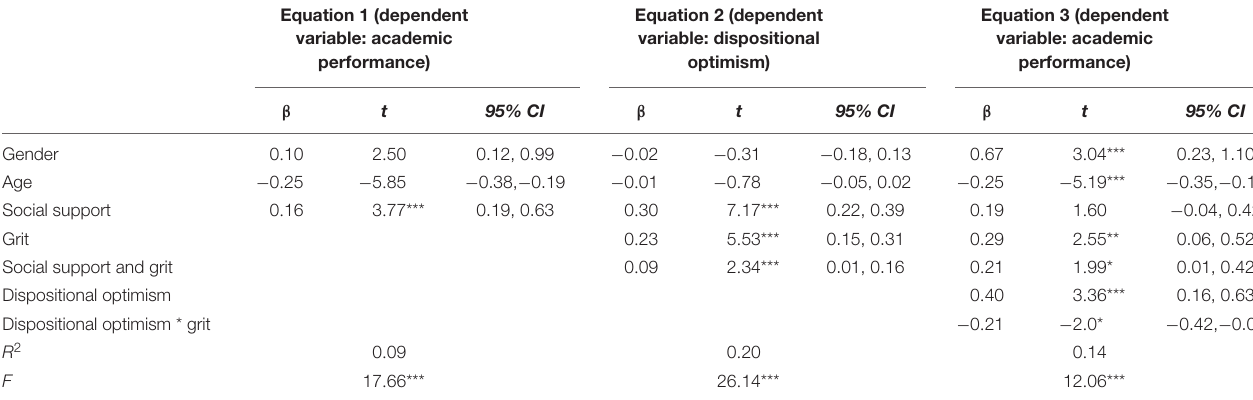
Equation 1 (dependent variable: academic performance)